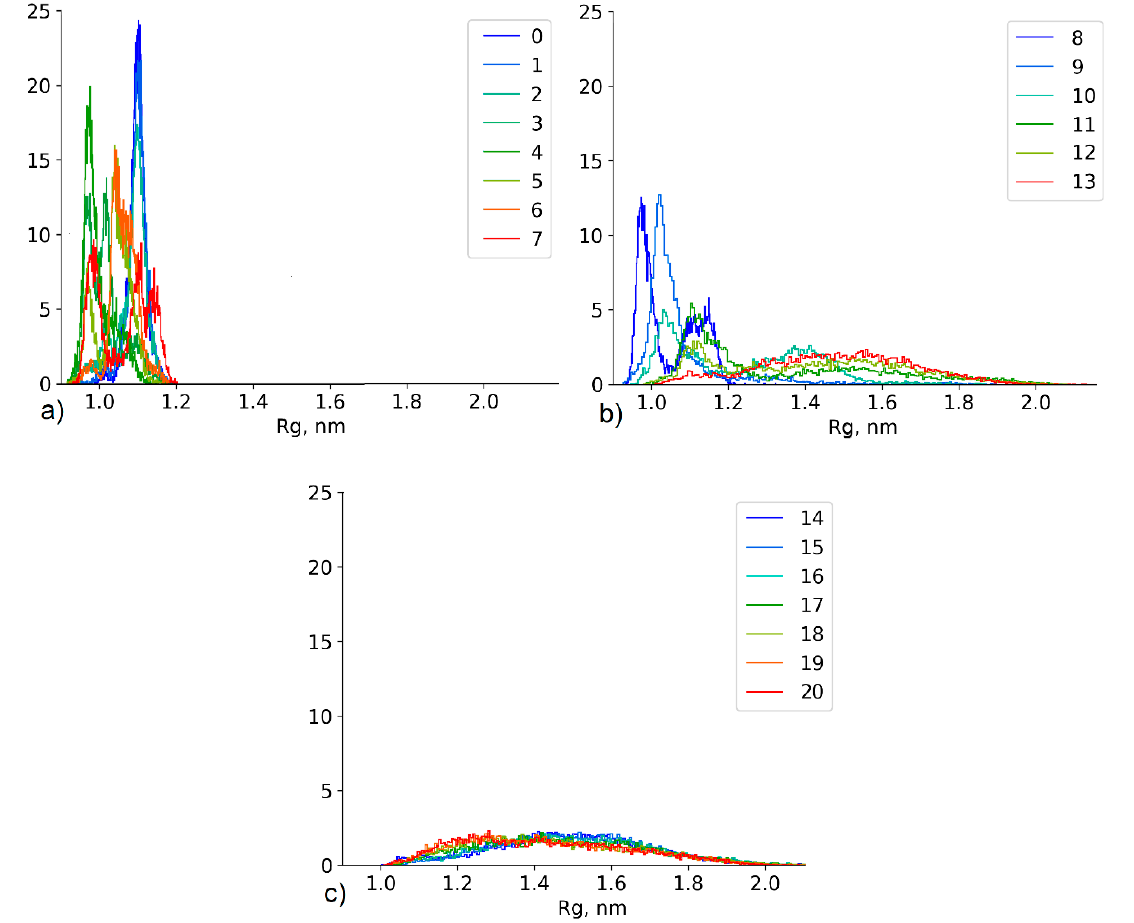
Figure 6. Radius of gyration distributions of PASA in 0.07 mol/kg CaCl 2 solution for all simulated replicas ( a ) 0–7 replicas ( b ) 8–13 replicas ( c ) 14–20 replicas.